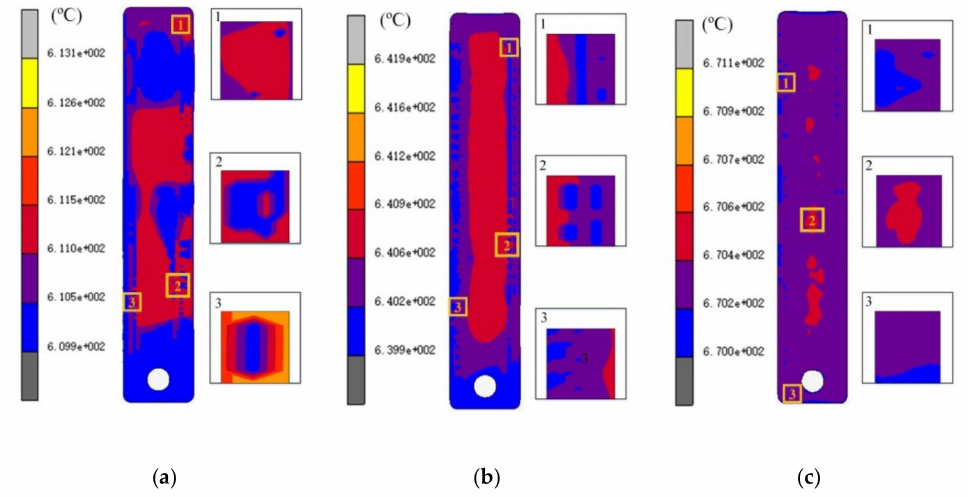
Figure 9. Temperature difference distribution results (molding temperature 610 ◦ C, 640 ◦ C, 670 ◦ C; heating rate 1.5 ◦ C/s, cooling rate 1 ◦ C/s). ( a ) The maximum temperature difference is 2.3 ◦ C; ( b ) The maximum temperature difference is 1.0 ◦ C; ( c ) The maximum temperature difference is 0.6 ◦ C.